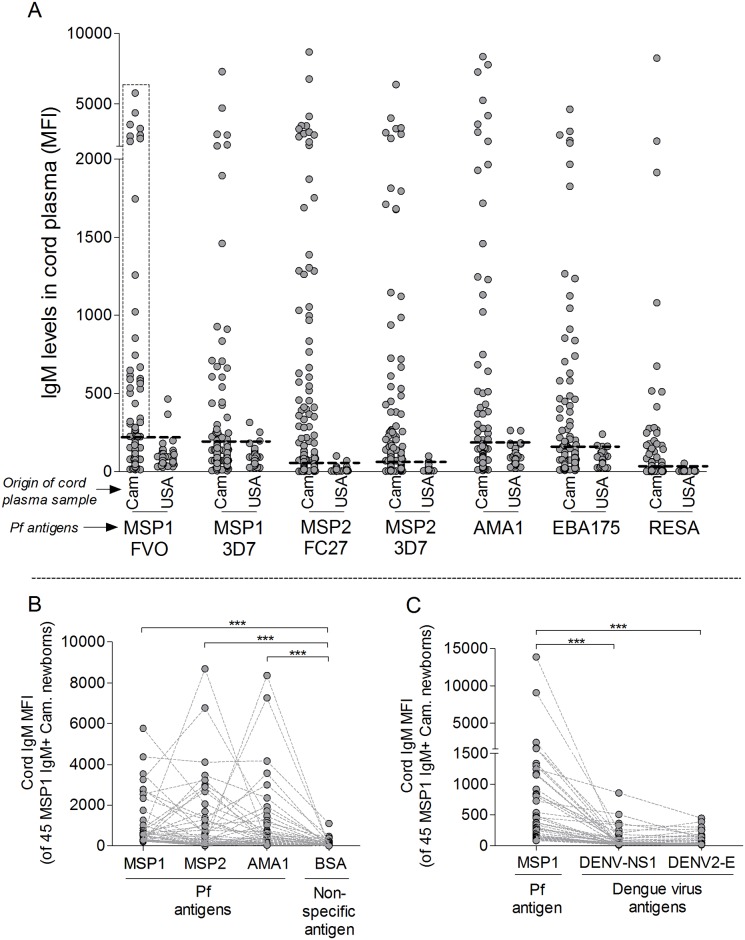
IgM to Pf antigens in Cameroonian and American cord plasma samples.(A) Distribution of levels of Pf IgM Abs in 682 Cameroonian (Cam) and 100 American (USA) cord plasma samples. The horizontal dotted lines represent the cut-off for IgM positivity (mean + 2 standard deviations of the USA controls). Only one or two American cord blood samples were above the cut-off for any of the malarial antigens and the samples appeared to be outliers based on the USA MFI distribution. The vertical dotted box within Cam MSP1-FVO shows 45 samples used in Fig 1B and C. The binding specificity of the 45 cord samples positive for IgM to MSP1-FVO was tested for (B) BSA and (C) two Dengue virus proteins (DENV-NS1 and DENV-2 E). The samples had IgM to Pf Ags but not to the non-malarial Ags. The MFI for a dengue IgM positive control was 4,003 MFI for DENV-NS1 and 847 MFI for DENV2-E (data not shown). Significance of differences in IgM MFI to Pf compared to control Ags was assessed using Wilcoxon signed-rank test (paired comparison): *p<0.01 and ***p<0.0001. MFI = Median Fluorescence Intensity.